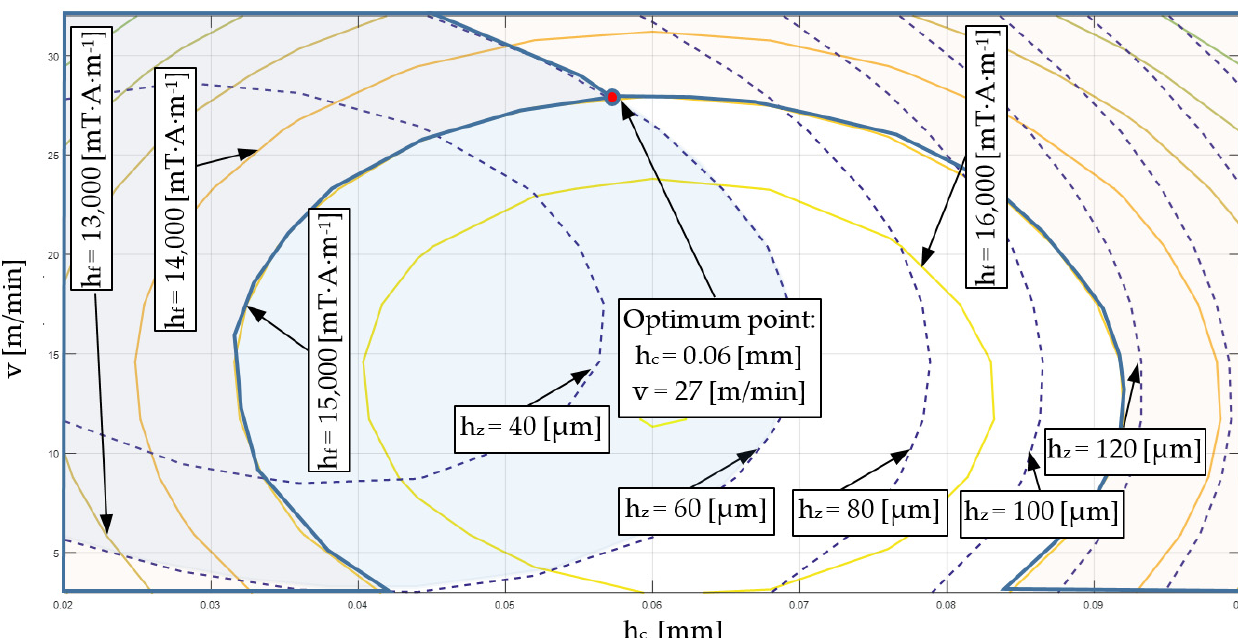
Figure 17. Graphical optimization of the cutting process.